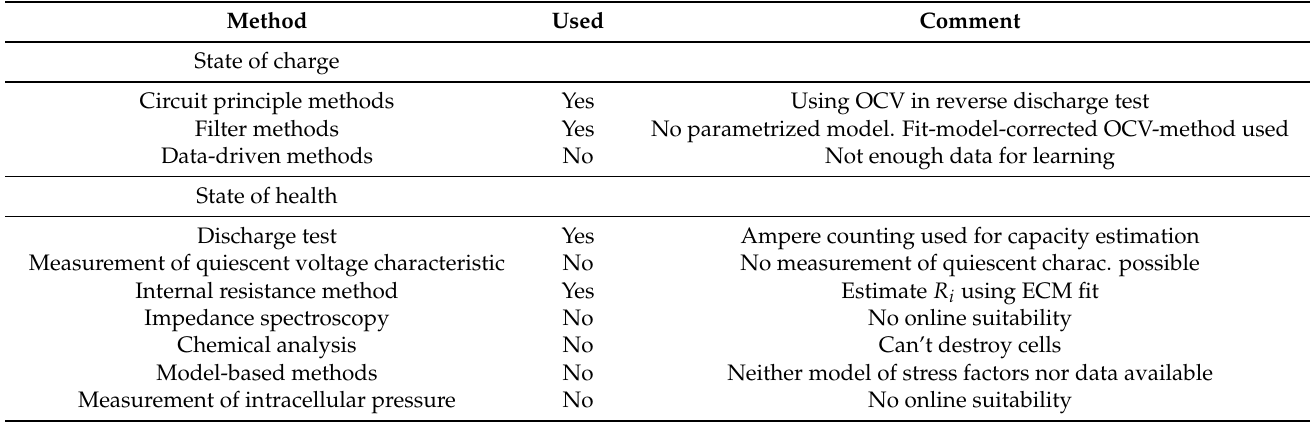
Table 1. Suitability of the methods for determining the state of health via the on board diagnosis (OBD) interface during real